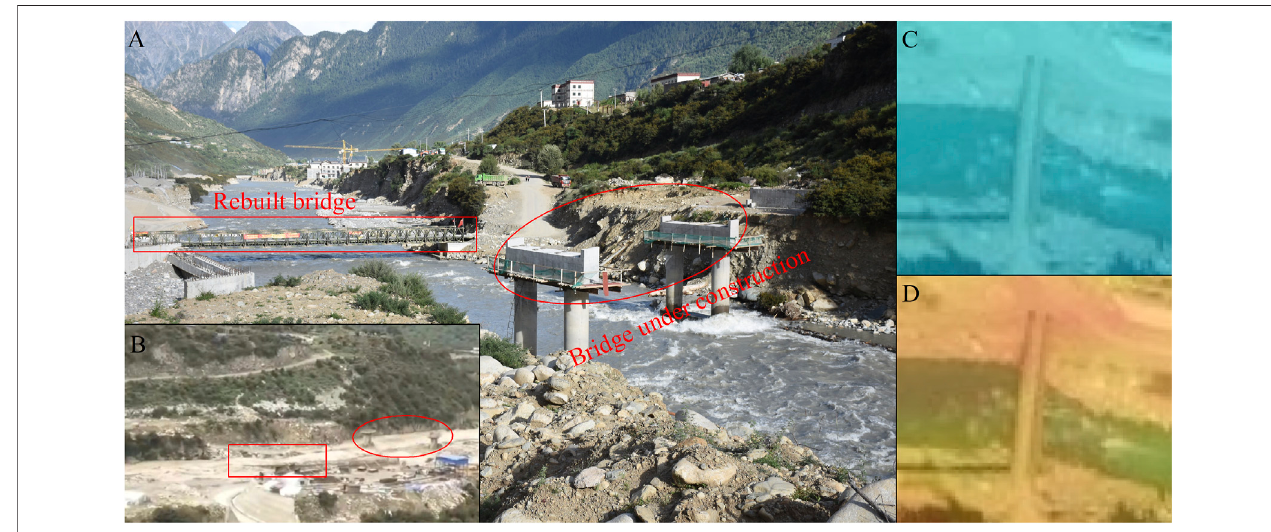
FIGURE 10 | (A) is the photo of two bridges in Zhongyu town taken by Yao on 25 August 2020; (B) is the photo taken by inhabitants on 26 June 2020, these two bridges were damaged by fl ood; (C) is the maximum depth in the steel bridge; (D) is the maximum velocity in the steel bridge.